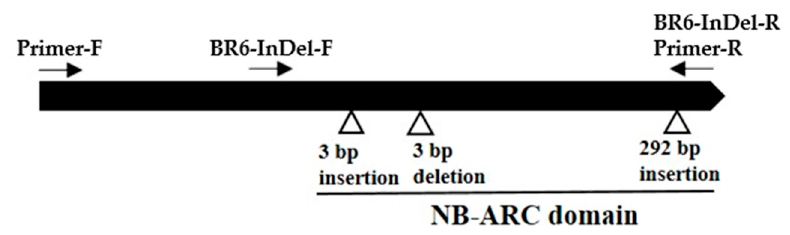
Figure 2. Primer location in R gene used in this study. ORF: Primer-F and Primer-F; Indel marker ‘BR6-InDel’: InDel-F and InDel-R.